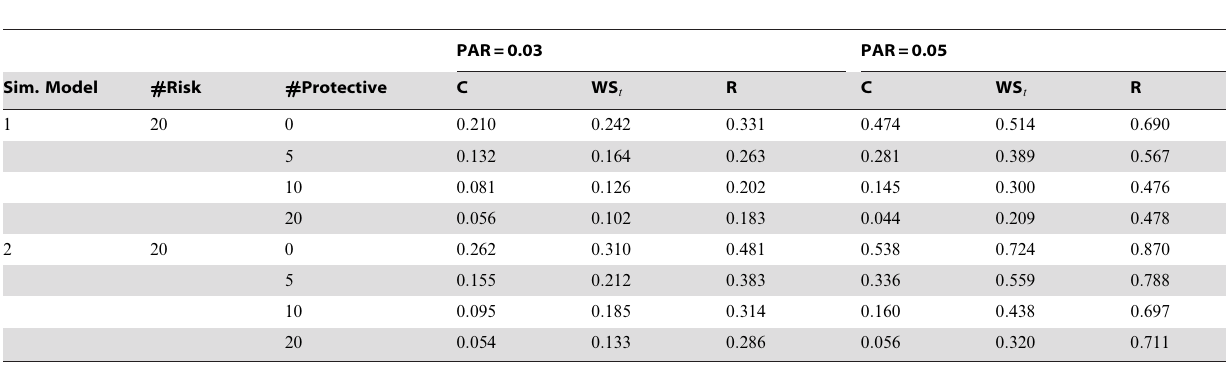
Table 4. Power Estimates ( a ~ 0 : 05 ) for two-sided tests, testing for the presence of risk or protective variants, when there is a mixture of risk and protective variants in the region of interest.